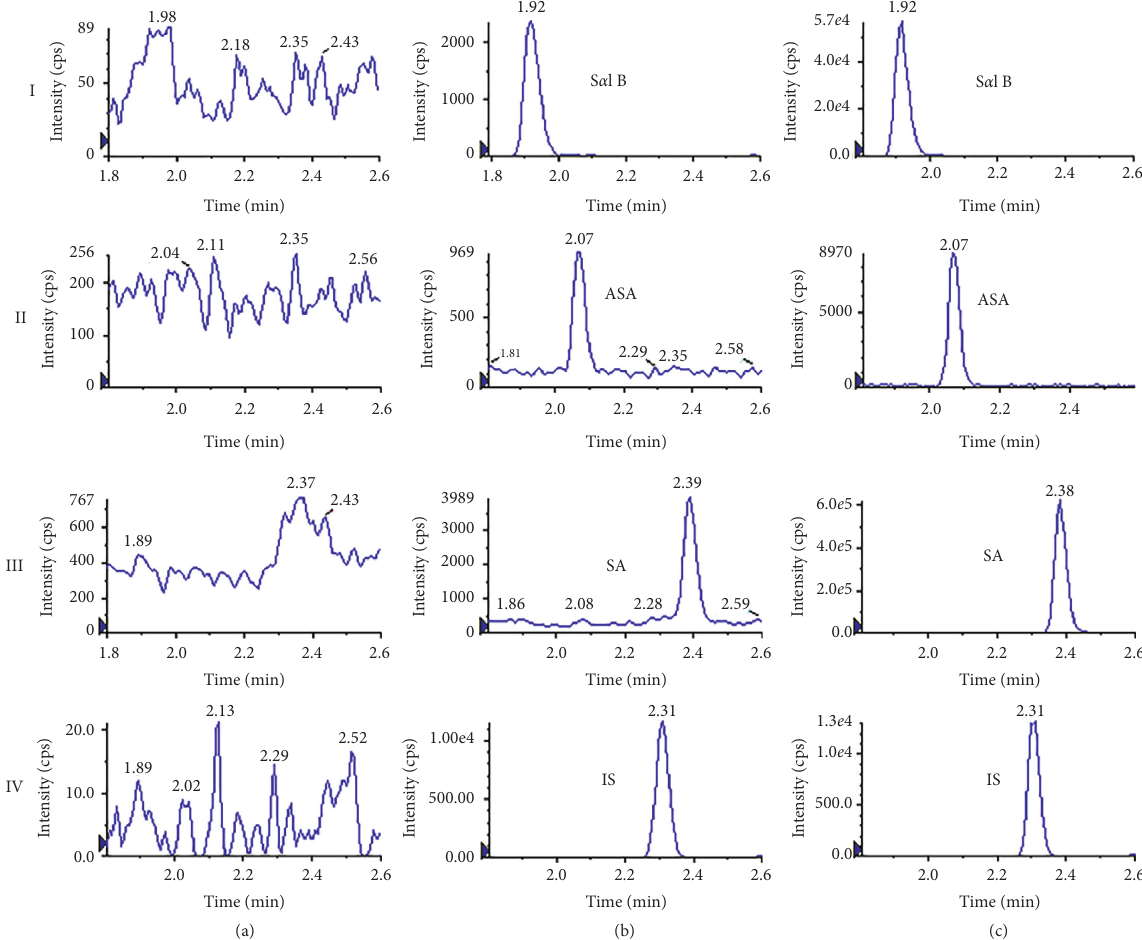
Figure 2: Representative MRM chromatograms of Sal B ASA, SA, and IS in plasma. (a) Blank plasma. (b) LLOQ sample (Sal B ASA, and SA at 5 ng/mL; IS at 20ng/mL). (c) Plasma sample 4h after